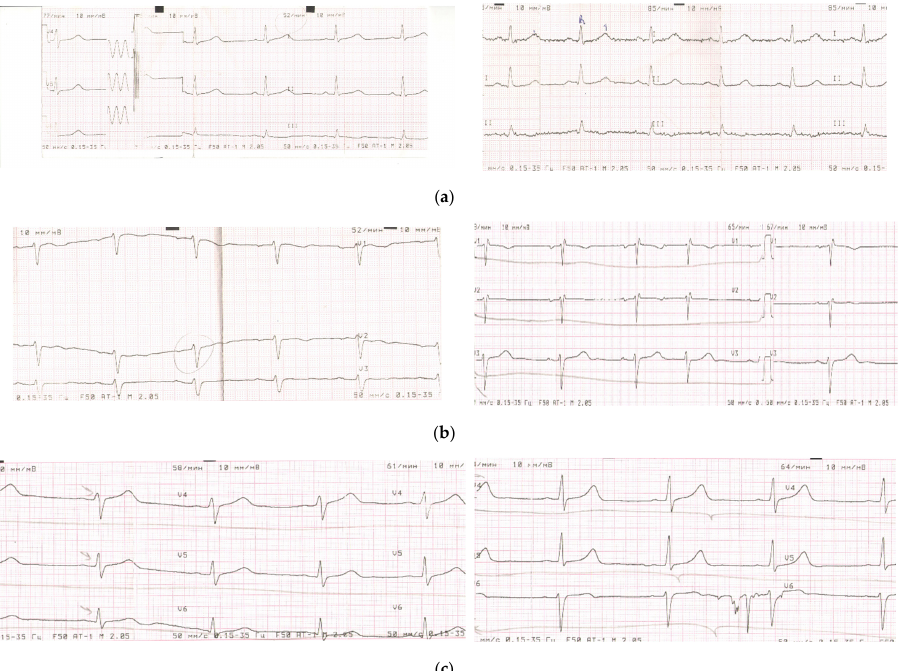
Figure A1. Examples of ECG in post-COVID period before and after clinical trial on the efficacy of FFS. ( a ) Left ECG-bradycardia of post-COVID patient A-va (severe COVID) at the 30th day after discharge from the hospital. Right ECG-normal ECG of the same patient at the 50th day after 20 days of FFS supplementation. ( b ) Left ECG-partial blockade of the left bundle of Hiss in post-COVID patient B-ev (severe COVID) at the 40th day after discharge from the hospital. Right panel-normal ECG of the same patient at the 60th day after 20 days of FFS supplementation. ( c ) Left ECG-dysmetabolic changes in myocardium of post-COVID patient L-ova (moderate COVID) at the 30th day after discharge from the hospital. Right panel normal ECG of the same patient at the 50th day after 20 days of FFS